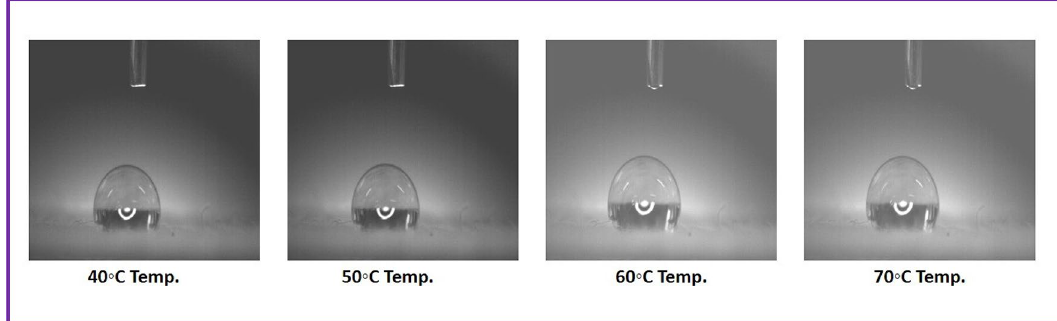
Fig. 8 Different contact angle at different temperature